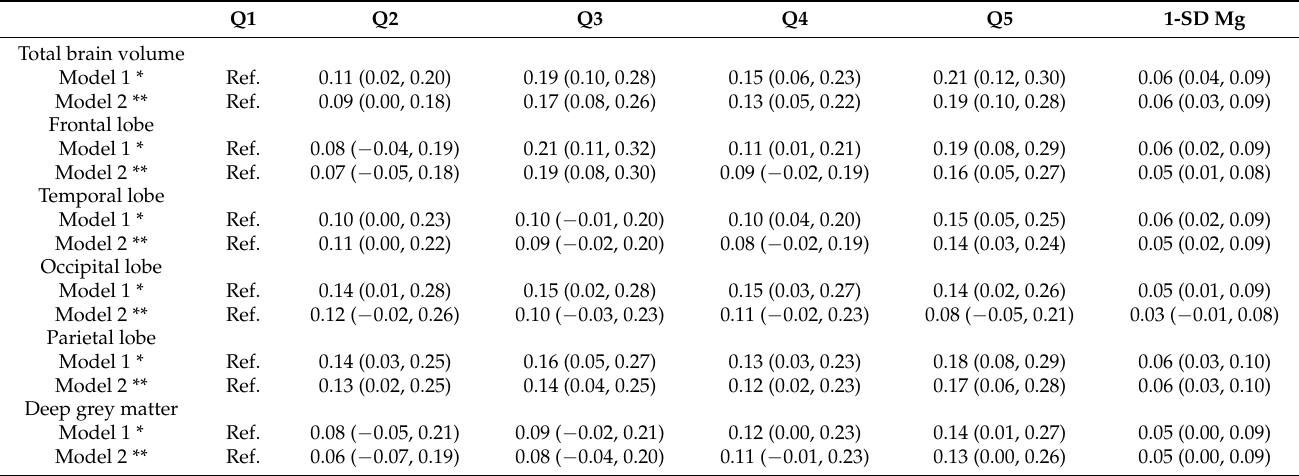
Table 2. Associations of serum magnesium with brain volumes, ARIC-NCS 2011–2013.